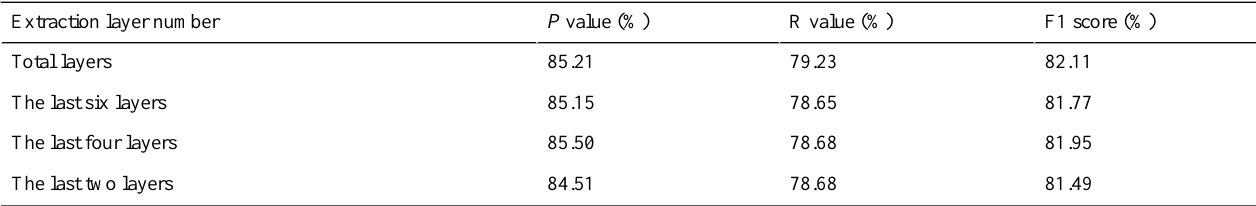
Table 6. The effect of extracted layer